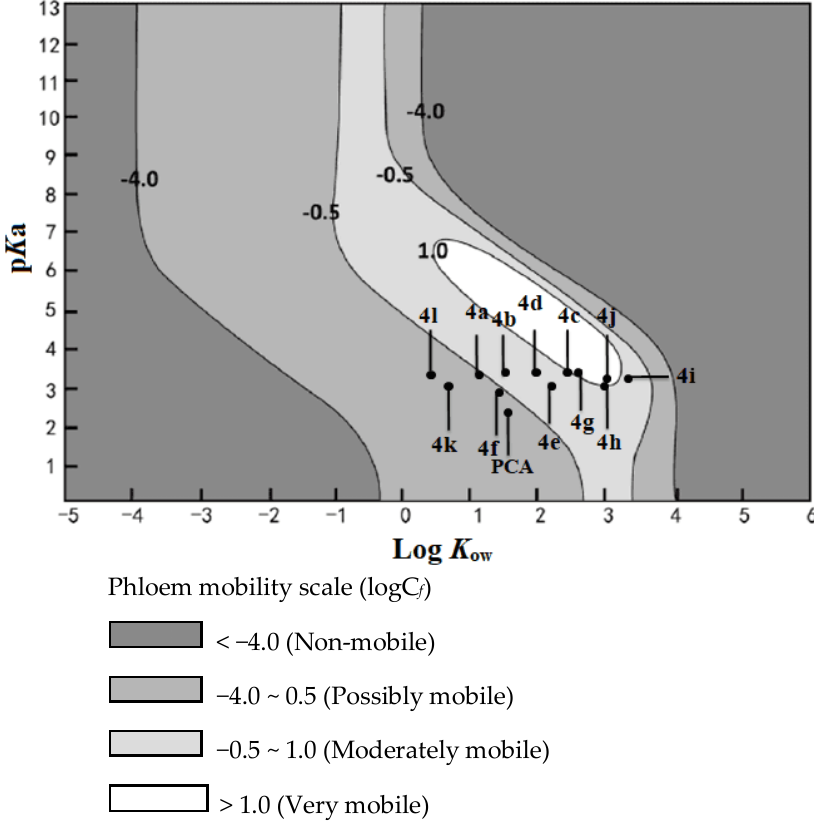
Figure 1. Prediction of phloem mobility of compounds 4a – l and PCA using the Kleier map (logC f as a function of p K a and Log K ow ).